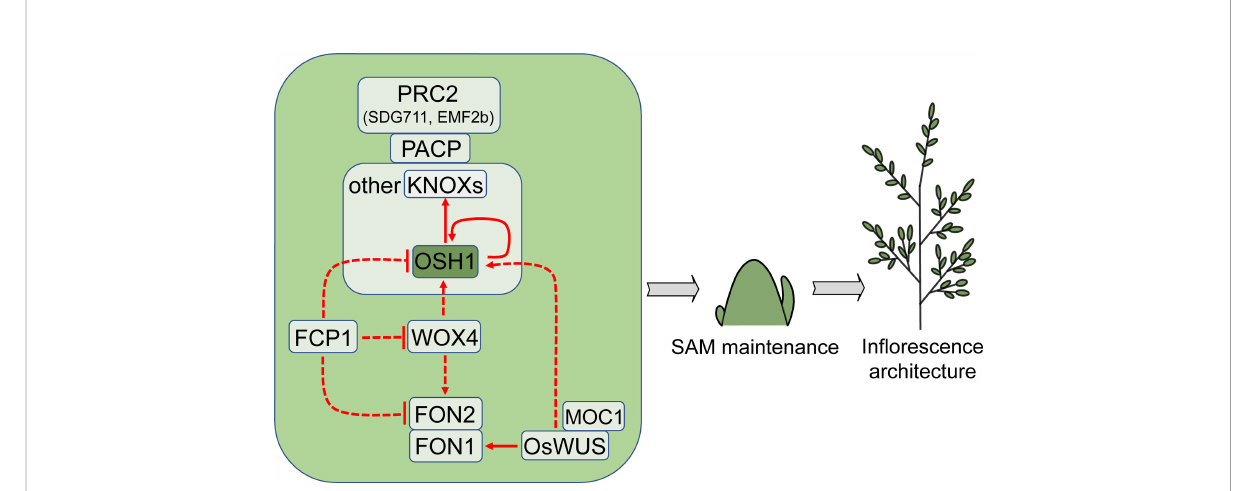
FIGURE 2 Regulators that control SAM or IM activity and affect in fl orescence architecture. OSH1 is a critical factor that is commonly used as a marker gene for rice SAM maintenance. Arrows and blocked arrows represent positive and negative regulation, respectively. Solid and dashed lines represent direct and indirect regulation, respectively. Red lines represent regulation at transcription level. SAM, shoot apical meristem; IM, in fl orescence